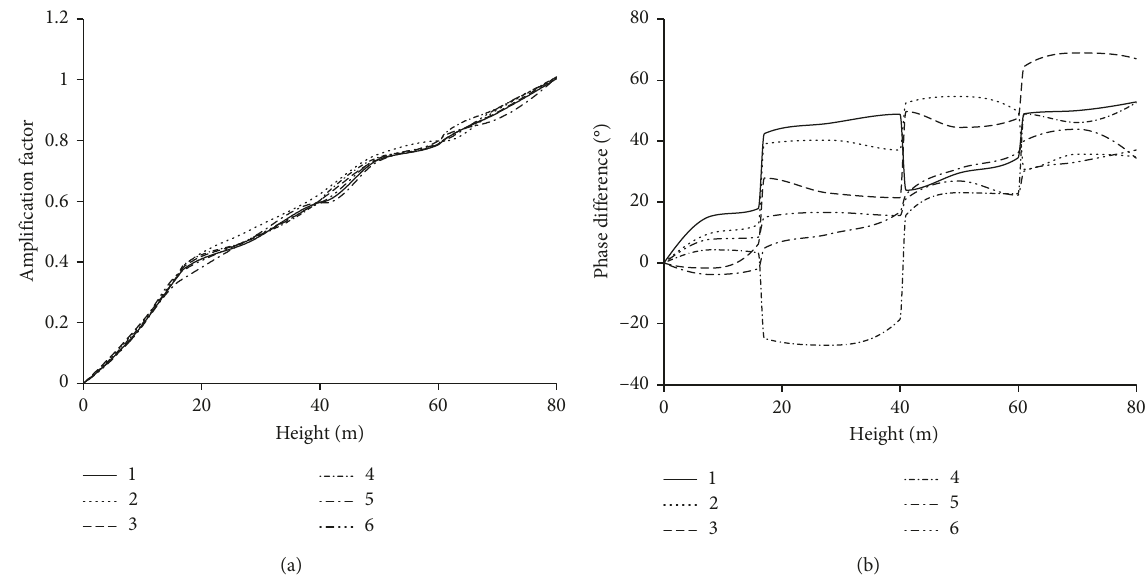
Figure 6: Vibration modes and phase differences of the No. 3 wind turbine tower. (a) The first-order vibration mode under six working conditions. (b) The first-order phase difference under six working conditions.